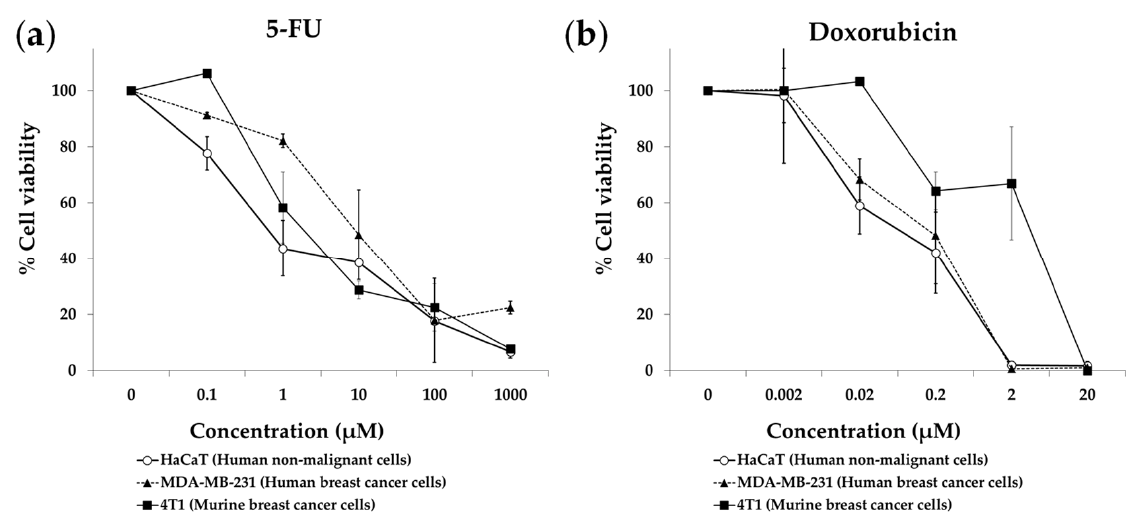
Figure 2. Cytotoxic effect of 5-fluorouracil ( a ) and doxorubicin ( b ) on triple-negative breast cancer cells and non-malignant cells. Cells were treated for 72 h, and cell viability was estimated with the MTT assay. Data show the mean ± SEM of at least 2 independent experiments.